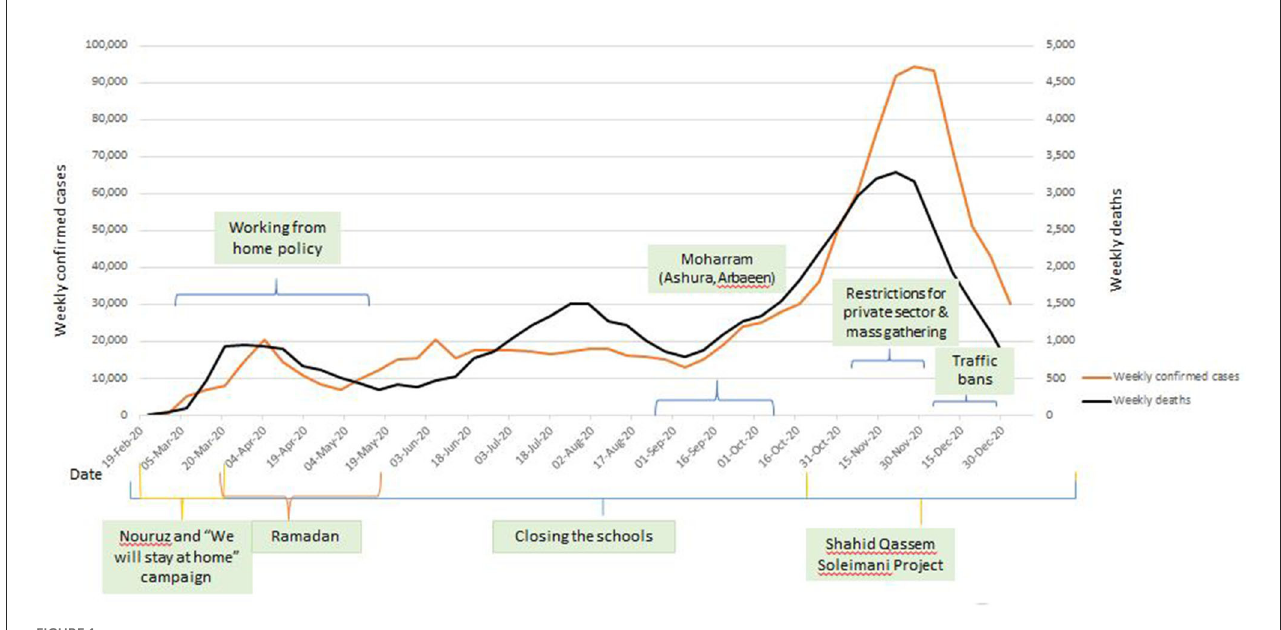
FIGURE1 COVID-19 epidemic curve with public health and social measures implemented in 2020.